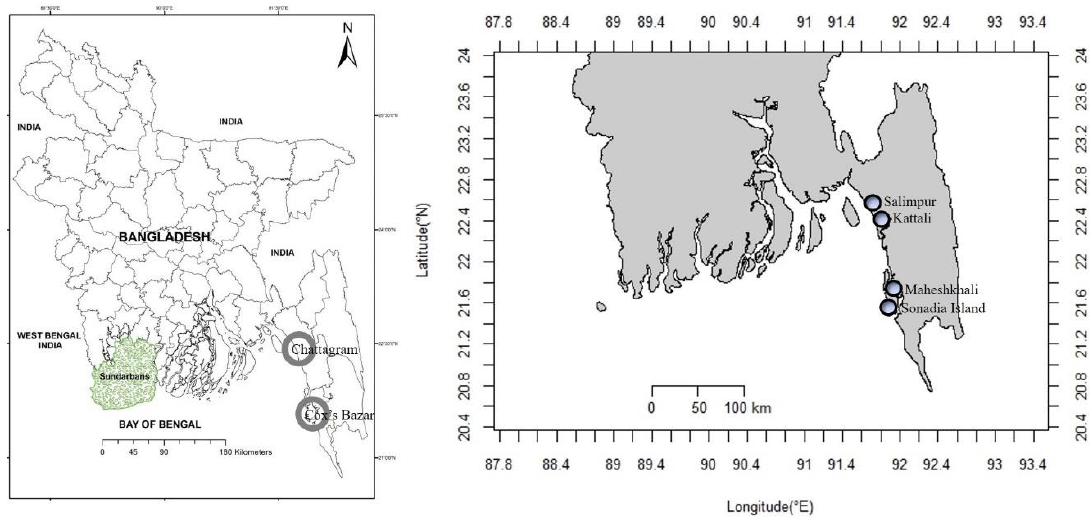
Figure 1. Location of the four study areas in Chattagram (Salimpur and Kattali) and Cox’s Bazar (Maheskhali and Sonadia) districts along the Bangladesh coast. Modified from [40].